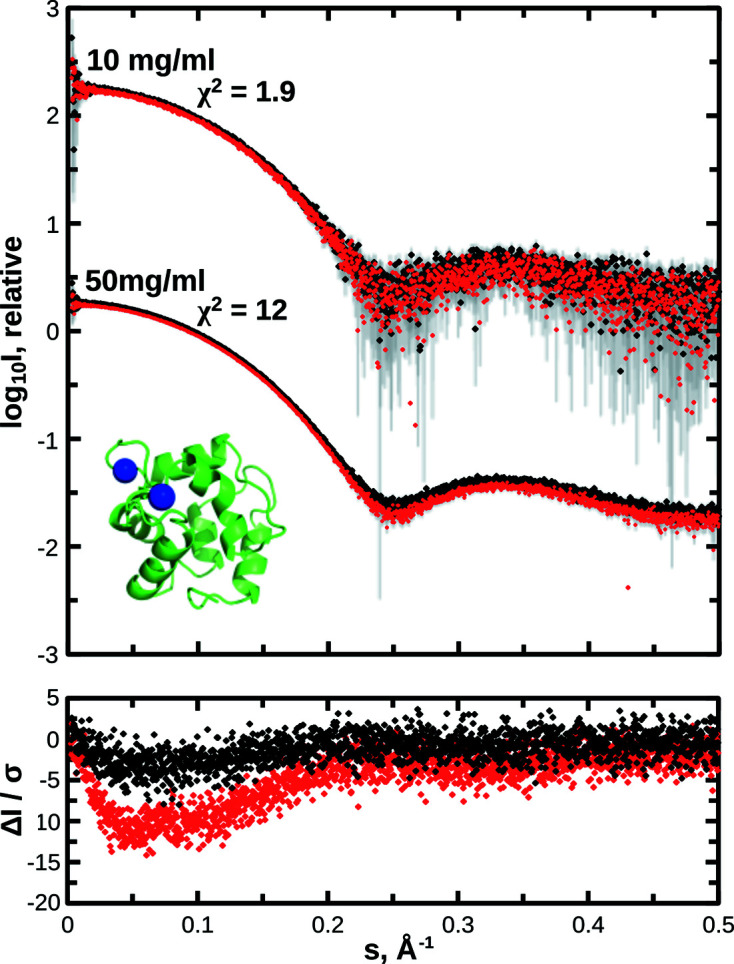
Simulated SAXS data for parvalbumin (PDB ID 1pal), with terbium atoms in two calcium-binding sites of the protein. Regular, wavelength-independent scattering (top panel, black) was computed with CRYSOL in default mode, while anomalous scattering (top panel, red) was evaluated with CRYSOL in anomalous mode, at the L
III absorption edge of terbium (7517 eV). Experimental data were simulated with IMSIM at two parvalbumin concentrations, 10 and 50 mg ml−1. DATCMP was used to compare regular and anomalous scattering at the two concentrations, showing greater differences at 50 mg ml−1 (details in Table 1 ▸). Residual plots on the bottom panel more clearly depict the differences between regular and anomalous scattering at 10 (black) and 50 mg ml−1 (red). At both concentrations, there is a reduction in forward scattering at the absorption edge. The difference between regular and anomalous SAXS is partly obscured by noise at 10 mg ml−1 but is more clearly visible at 50 mg ml−1 parvalbumin.